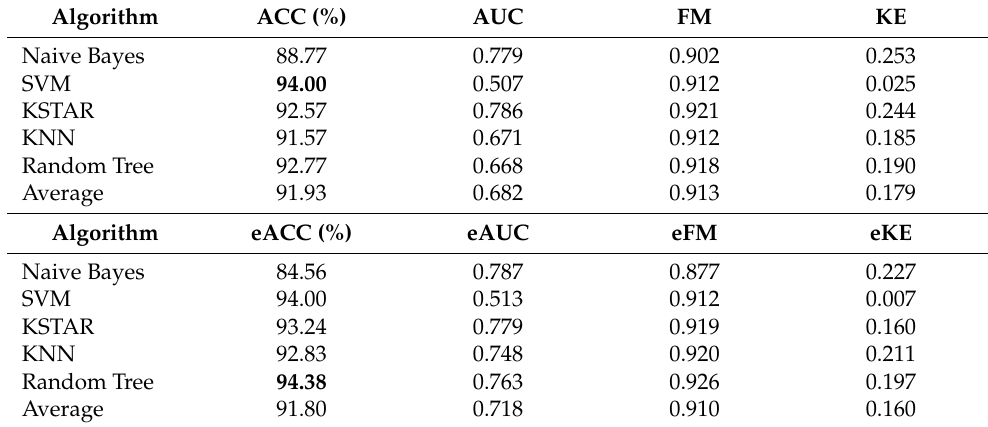
Table 9. Classification results for Active MQ data